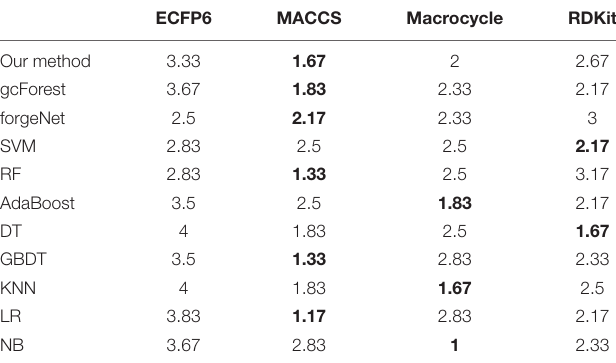
TABLE 4 | Averaged ranking scores of 11 methods with 3